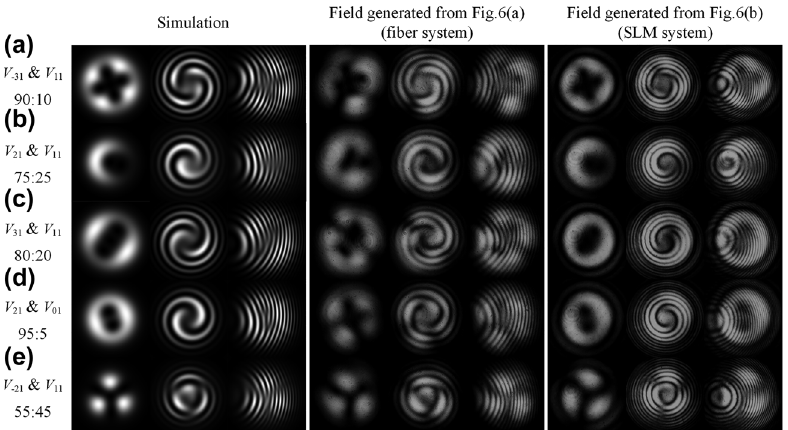
Figure 7: Experiment and simulation results of hybrid-order vortex lights generated by